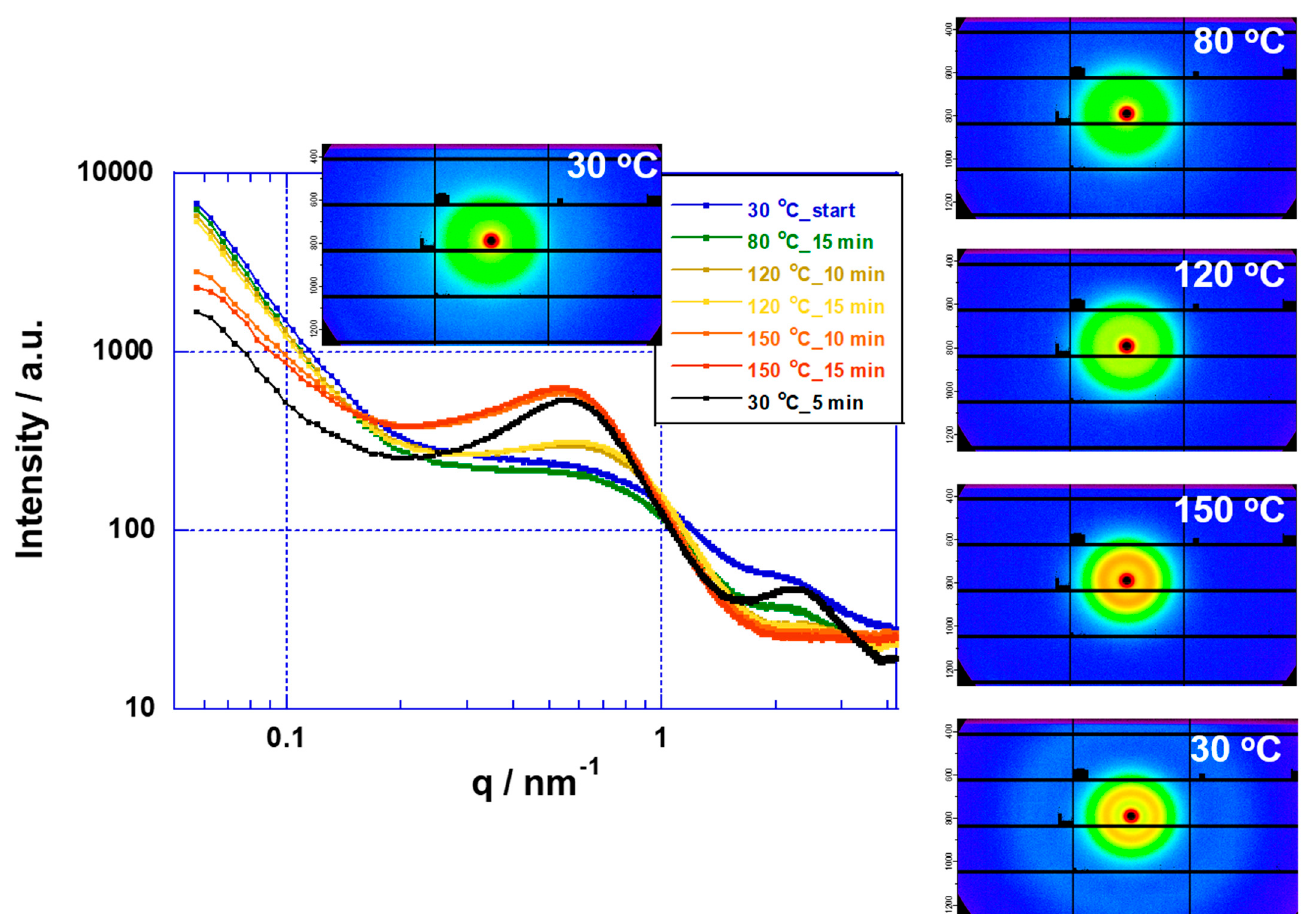
Figure 6. SAXS profiles for Nafion membrane at various temperatures.